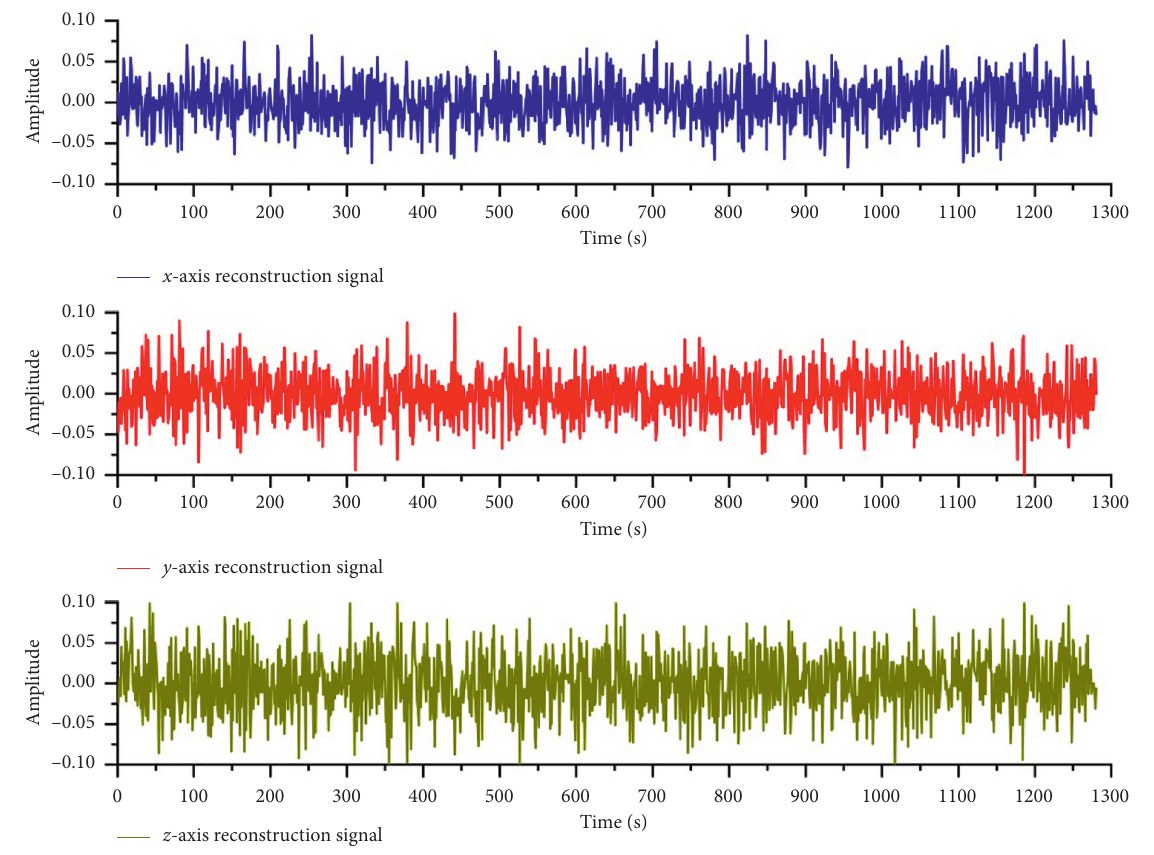
Figure 7: Three-axis reconstruction signal.